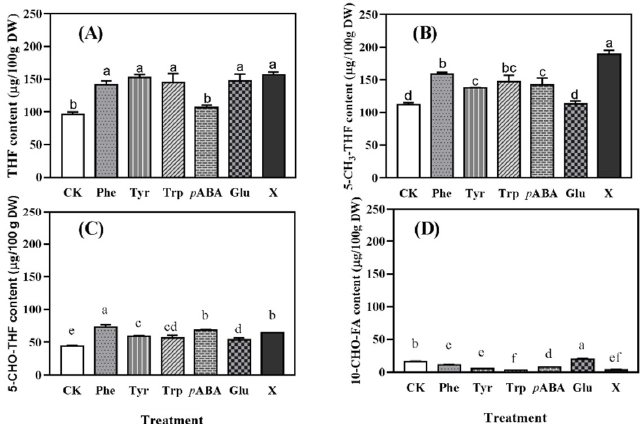
Figure 2. Contents of tetrahydrofolate ( A : THF), 5-methyltetrahydrofolate ( B : 5-CH 3 -THF), 5- formyltetrahydrofolate ( C : 5-CHO-THF), and 10-formylfolic acid ( D : 10-CHO-FA) in wheat seedlings. CK was the wheat seedlings cultured with distilled water; Phe, Tyr, Trp, p ABA, and Glu were seedlings cultured with 1.00 mM phenylalanine, 0.25 mM tyrosine, 0.50 mM tryptophan, 0.25 mM p -aminobenzoic acid, and 1.00 mM glutamate, respectively; X was seedlings cultured with the opti- mized culture solution (1.50 mM phenylalanine, 0.50 mM tyrosine, 0.50 mM tryptophan, 0.75 mM p -aminobenzoic acid, and 0.50 mM glutamate). a–f represent significant differences among treatment factors ( p < 0.05).